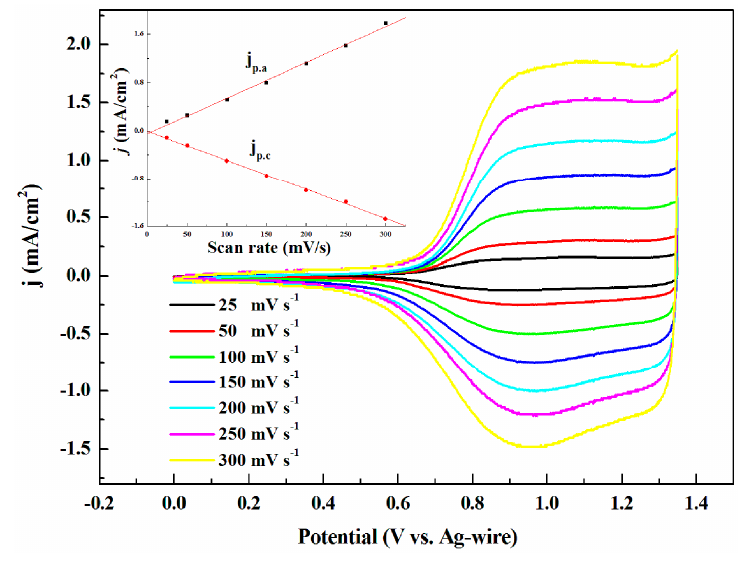
Figure 3. CV curves of P1 for p-type doping process at various scan rates. Insert: graphs of scan rate vs. peak current density.